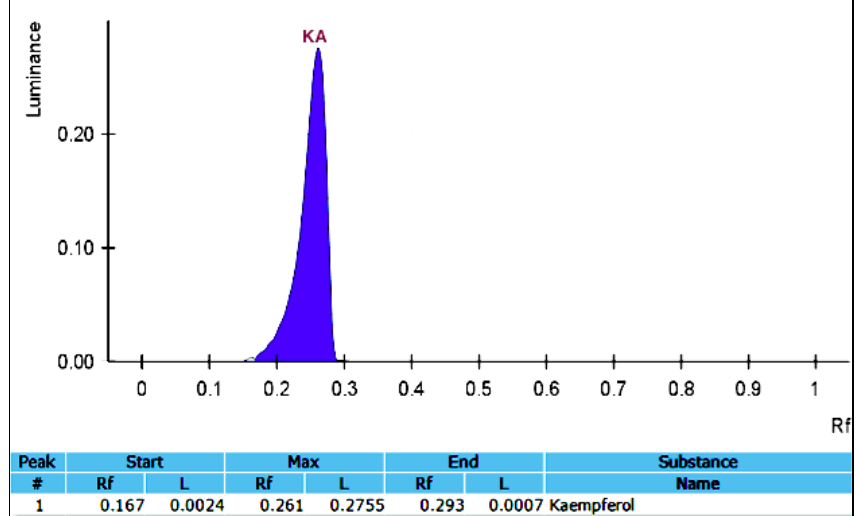
Figure 3. High performance thin layer chromatography (HPTLC) chromatogram of the KA standard. Rf, Retention factor. #, number; L, lowest distance.